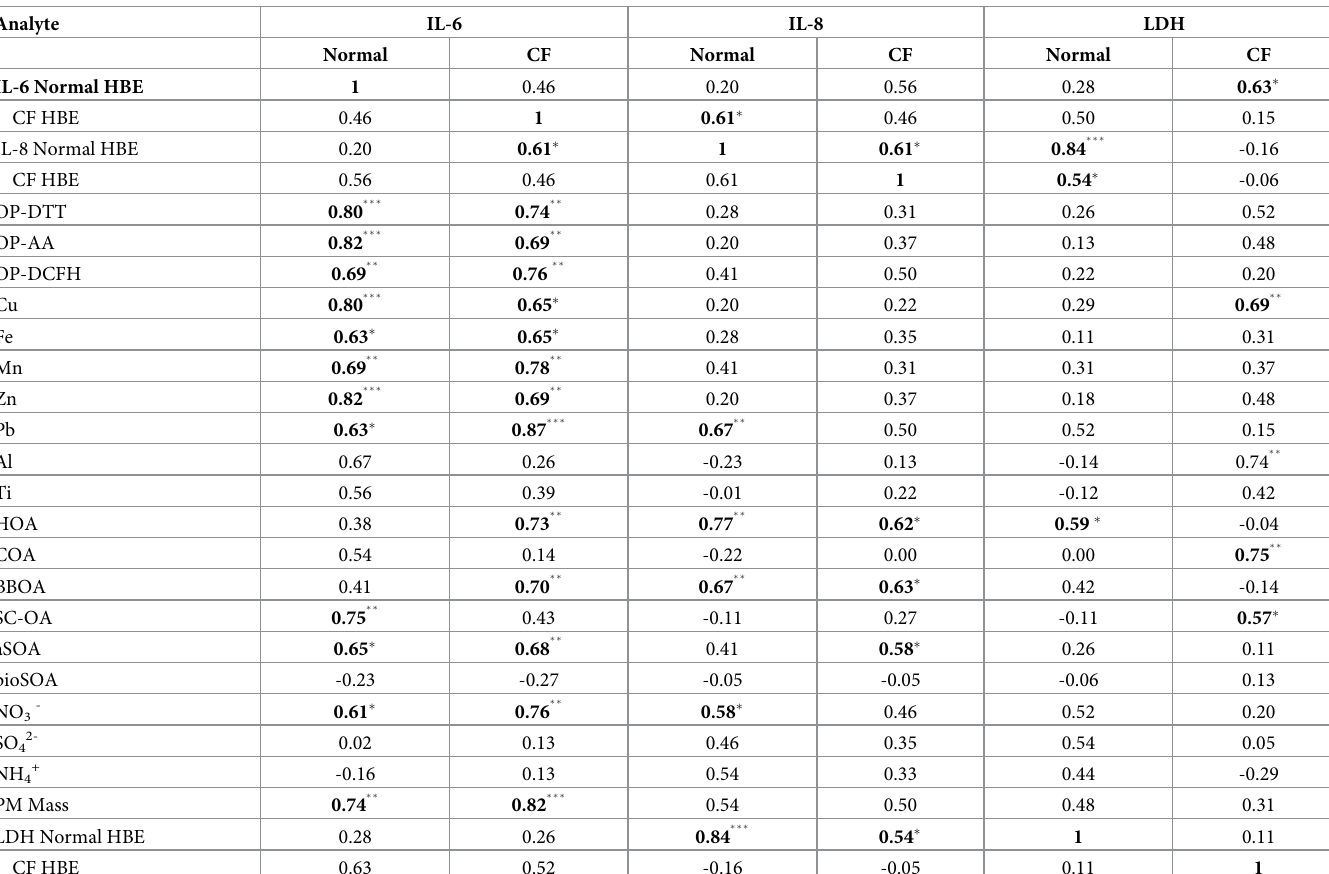
Table 3. Association between cellular responses of normal and CF HBE to PM exposure and physico-chemical parameters of the PM.